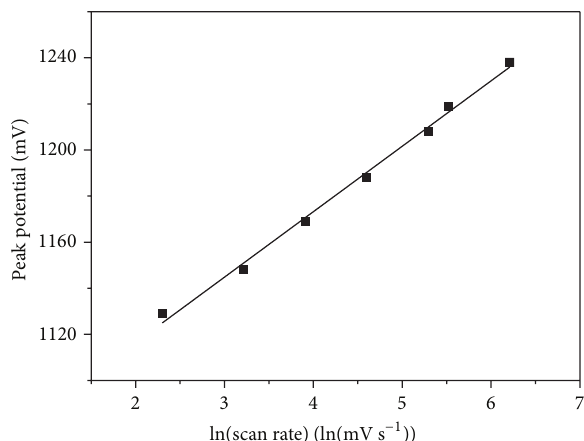
Figure 3: Dependence of the peak current on pulse amplitude in the range of 10 to 100mV and step potential in the range of 1 to 7 mV for 10 𝜇 M codeine in 0.1 M phosphate buffer (pH 3.0) volume of Nafion/MWCNTs 10 𝜇 L. Other instrumental parameters: 𝑡 𝑤 , 𝑡 𝑠 = 20 ms, preconcentration potential 300 mV, preconcentration time 20 s, and stirring rate 500 rpm.